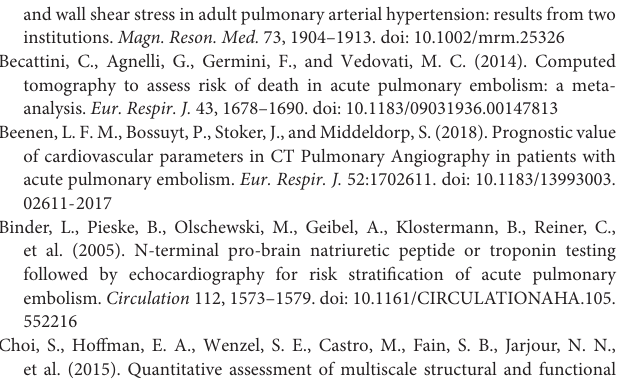
FIGURE S1 | The histograms of quantitative variables for the exhibition of distribution plots. (A) Age; (B) MPA inlet maximal diameter; (C) MPA inlet CSA; (D) MPA inlet hydraulic diameter; (E) MPA outlet maximal diameter; (F) MPA outlet CSA; (G) MPA outlet hydraulic diameter; (H) RPA inlet maximal diameter; (I) RPA inlet CSA; (J) LPA inlet hydraulic diameter; (K) MPA bifurcation area; (L) MPA bifurcation angle; (M) MPA bifurcation volume. FIGURE S2 | The selection of the LASSO mathematical model. Two LASSO predictive models were conducted by 10-fold cross-validation based on minimum criteria (lambda.min criteria) and 1 standard error criteria (the 1-SE criteria) in the training set. Formula 1 (the 1-SE criteria): Select lambda = lambda.1se: 0.0668 ( − 2.7065). Variables selected: formula for calculating the score (not including intercept): 0.10 × MPA outlet CSA + 0.92 × MPA bifurcation area + 0.50 × MPA outlet hydraulic diameter, in which three parameters were involved. Formula 2 (lambda.min) formula for calculating the score (not including intercept): 0.27 × MPA outlet CSA + 1.92 × MPA bifurcation area + 2.01 × MPA outlet hydraulic diameter − 0.45 × Left-planet hydraulic diameter − 1.17 × MPA outlet maximal diameter − 0.53 × Right-planet hydraulic diameter − 0.44 × LPA inlet maximal diameter, in which severe parameters were involved. The detail procedure for the measurement of the index in Formula 1 and Formula 2 was shown in Supplementary Videos 1, 2 , respectively. Good predictability was achieved in the LASSO mathematical model by each formula. In the training set, the ROC-AUC was 0.897 (95% CI: 0.837–0.941, p < 0.05) and 0.860 (95% CI: 0.795–0.912, p < 0.05). More parameters (7 parameters) were involved in formula 2, and twice the time as that consumed by formula 1 (3 parameters) was required. Thus, we chose formula 1 (the 1-SE criteria) with the similar predictability but fewer parameters as the prediction method, which might work as a potential and practical tool in clinical practice. FIGURE S3 | The precision-recall (PR) curve of the training set and validation set for predicting the adverse events of the non-high-risk PE patients. The predictive formula was strongly better than that of evaluating the MPA dilation at the transverse section in the PR curve of the training set and validation set for predicting adverse events (mean precision: 0.71 vs. 0.23 and 0.55 vs. 0.23, respectively). (A) PR curve in training set; (B) PR curve in validation set. Redline is shown to indicate LASSO model; Greenline is shown to indicate MPA dilation. MPA dilation was evaluated by measuring MPA diameter at the transverse section plane (dichotomized at 29 mm as baseline) and was defined as ( + )/( − ) on CTPA. FIGURE S4 | The decision curve analysis (DCA) showed that utilizing the predictive formula for predicting adverse events added a net benefit both in the training set and in the validation set (range between 0.04 and 1.00 and 0.01 and 0.55, respectively). (A) DCA in the training set; (B) DCA in the validation